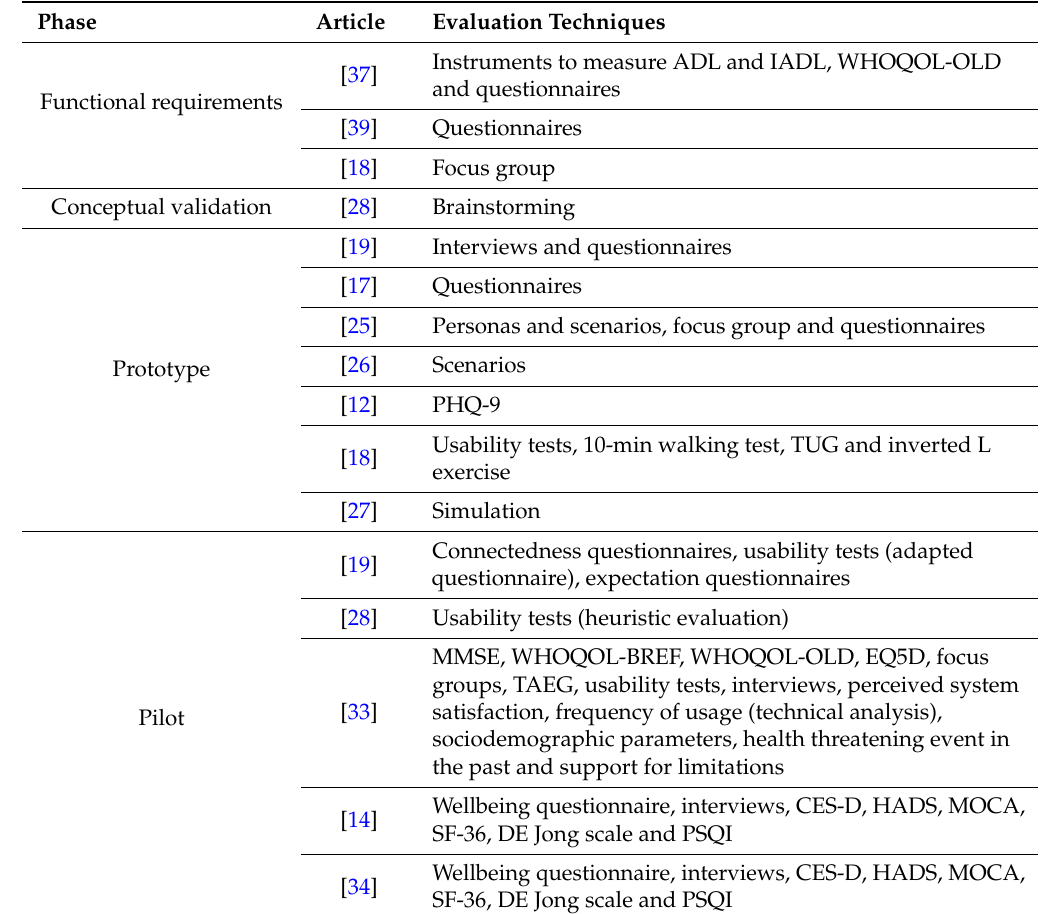
Table 5. Evaluation methods and